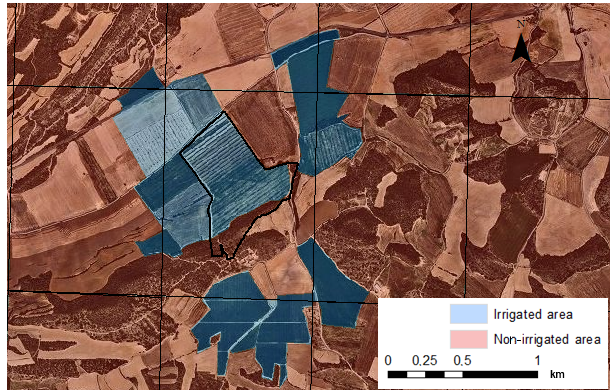
Figure 2. The DISPATCH grid representing the Foradada field, out- lined in dark blue, irrigated fields in light blue, and dry land in light